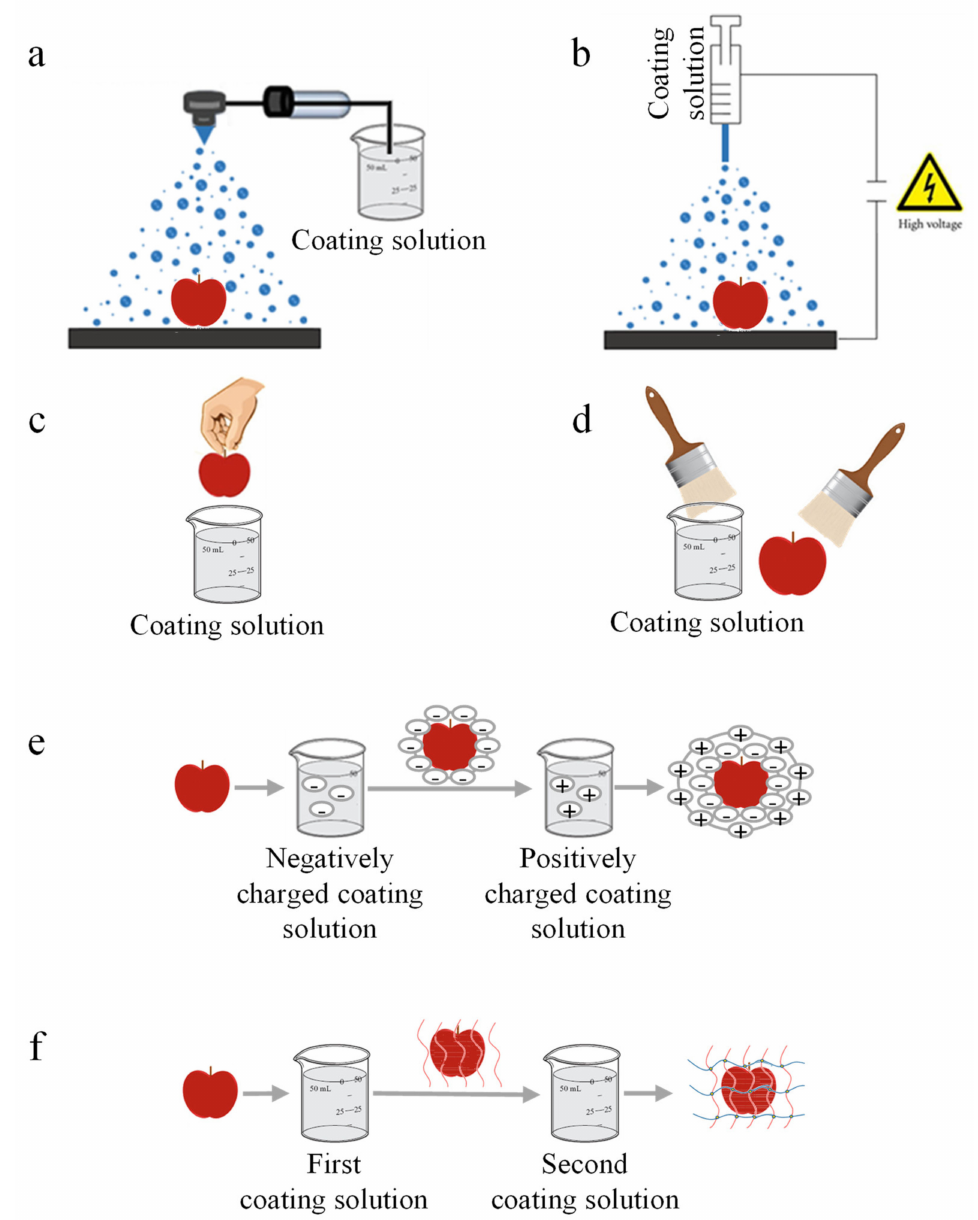
Figure 1. Schematic representation of the main coating deposition methods: ( a ) spraying method, ( b ) electrospraying method, ( c ) dipping method, ( d ) spreading method, ( e ) layer-by-layer coating deposition, and ( f ) cross-linked